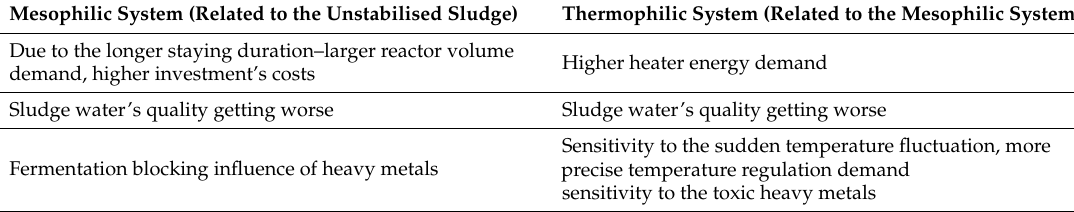
Table 4. Respective disadvantages of mesophilic and thermophilic digestion systems. Source: [24]. Mesophilic System (Related to the Unstabilised